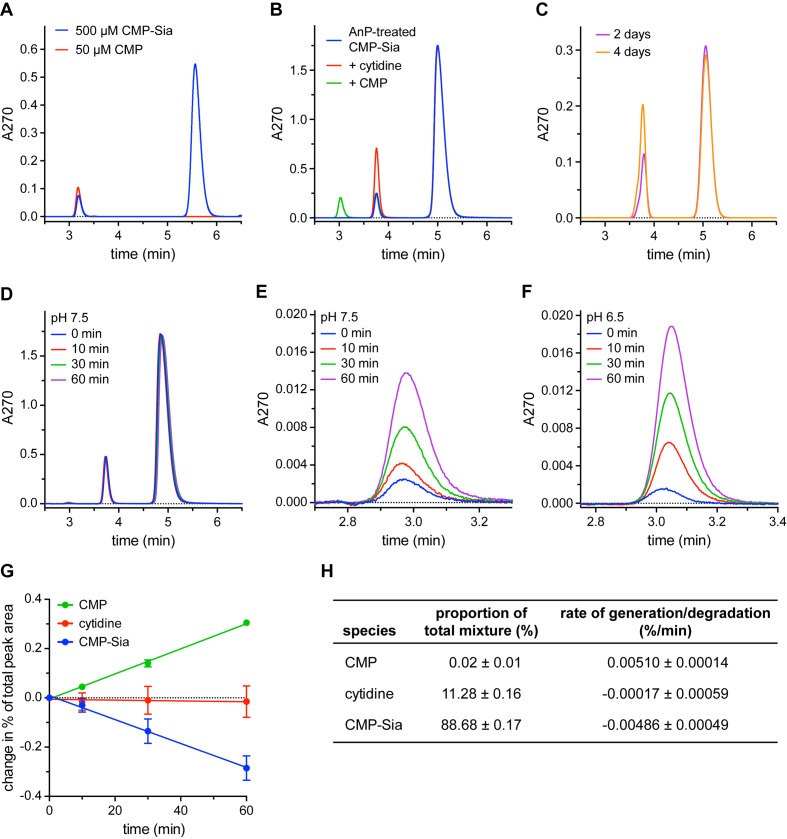
Detection and elimination of CMP contaminants in CMP-Sia stocks.(A) Two peaks were observed when a CMP-Sia stock was run on a C18 column (blue trace). Subsequently running a CMP stock on the same column (red trace) identified the first peak in the CMP-Sia sample as CMP. (B) Adding Antarctic phosphatase (AnP) to CMP-Sia shifts the elution time of the first peak from ~3 min to ~3.8 min. Running samples where either cytidine (red trace) or CMP (green trace) is mixed with the AnP-treated CMP-Sia shows that the AnP converts the CMP to cytidine. (C) To demonstrate the long-term stability of AnP, CMP-Sia was incubated with AnP at 20°C for the indicated time before running on the C18 column. (D–F) To determine the rate of CMP formed from CMP-Sia hydrolysis, AnP-treated CMP-Sia (with the AnP removed) was incubated at room temperature for the indicated time in either a pH 7.5 buffer (D, E) or a pH 6.5 buffer (F). (E) highlights the CMP peak at ~3 min from the chromatograms in (D); likewise, (F) shows the CMP peak from a similar set of chromatograms for an experiment performed at pH 6.5. In all the experiments shown in (A–F), small differences in elution times from run to run were sometimes observed and are most likely due to partial phase dewetting from using a 100% aqueous mobile phase. (G) The proportion of each of the three species from the series of chromatograms shown in (D), as well as from another independent time-course experiment, was calculated by dividing the area under the curve for each peak by the total area of all peaks combined. The proportion at 0 min was subtracted from the proportion at the other time points to give the change in proportion over time, which is graphed. See the Methods for more details. (H) The starting proportion of each species in a given AnP-treated CMP-Sia sample is listed. The slope from a linear regression fit to each of the data series in (G) gives the respective rates of species generation or degradation The symbols in (G) represent the mean and the errors in (G) and (H) represent SEM for n = 2.